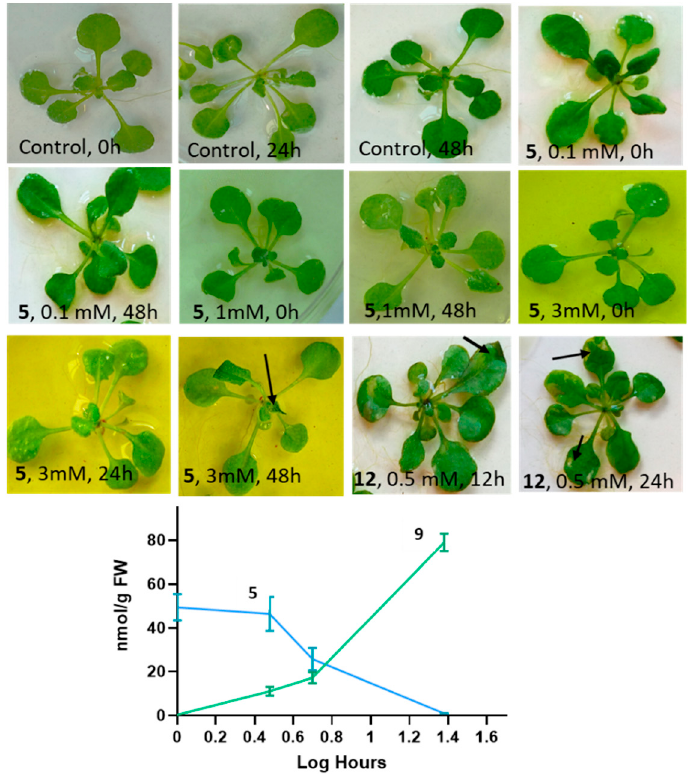
Figure 8. Phenotype of Arabidopsis plants exposed to 5 for 0, 24, and 48 h in comparison to 0.5/1.0 mM 6-hydroxy-5-nitrobenzo[ d ]oxazol-2(3 H )-one ( 12 ) (incubation times 12 and 24 h). Overall, 12 severely damaged the leaves (arrows). With 5 , only the highest concentration (3 mM) led to wilting of young leaves after 48 h (arrow). The graph shows the decrease in 5 (blue line) and accumulation of its glucosylated derivative 9 (green line) in Arabidopsis plants after 1, 3, 5, and 24 h of incubation with 1 mM 5 .